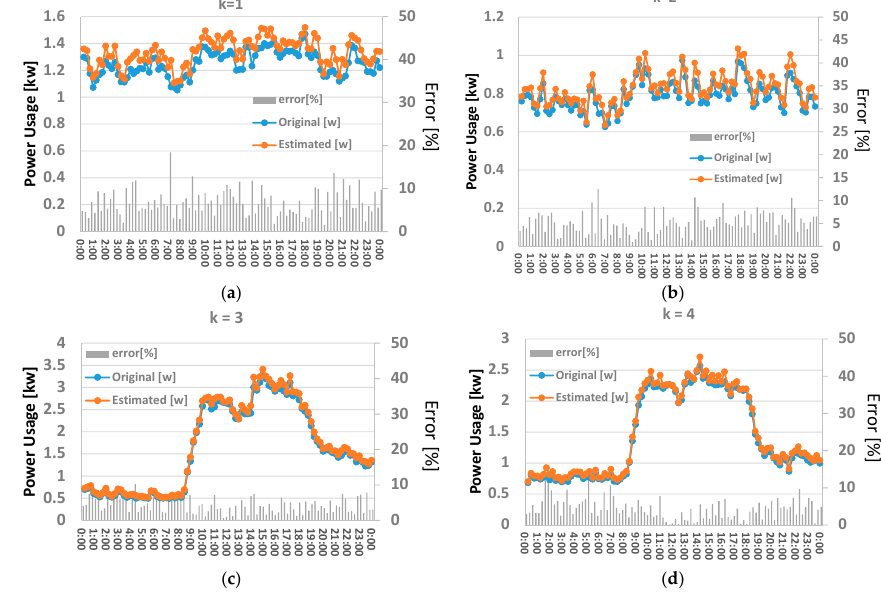
Figure 12. Estimation result of missing meter readings at T-node(2) for each representative ( a ) Group1; ( b ) Group2; ( c ) Group3; and ( d ) Group4. Table 2. MAPE of the estimation result for each estimation method.